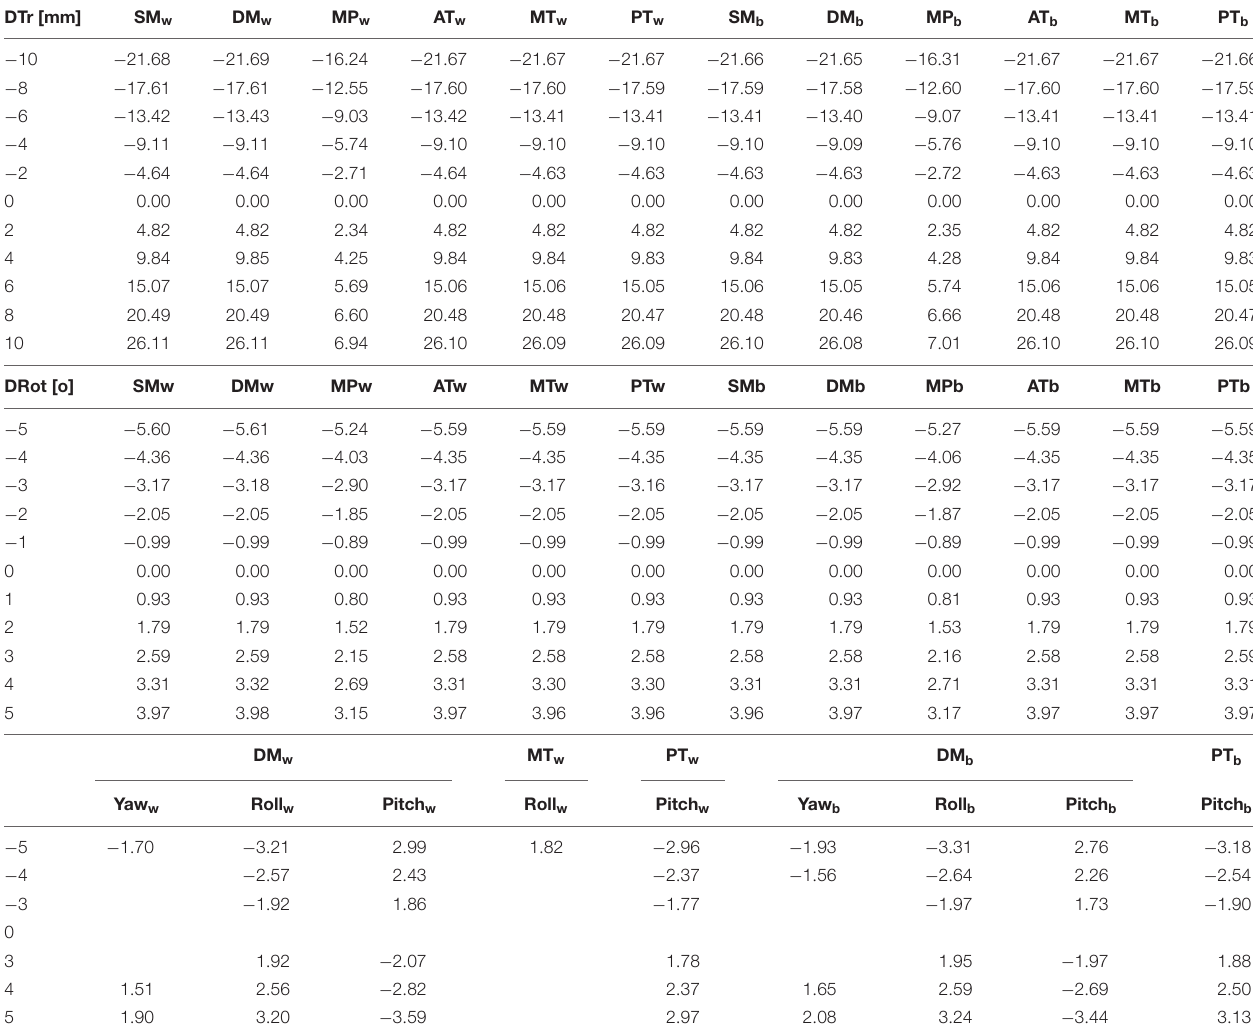
TABLE 3 | Percentage changes in the value of muscle forces when displacing the distal segment along the sagittal axis (DTr), the rotation of the distal segment along the transverse axis (DRot), the rotation of the proximal segment (Yaw, Roll, Pitch); S0- preoperative geometry model; abbreviations presented in Figure 2